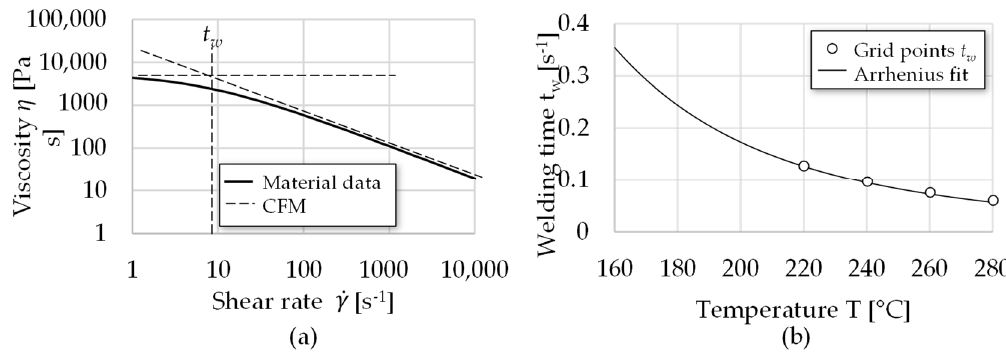
Table 2. Welding time of polypropylene (Moplen HP501H) at different temperatures.